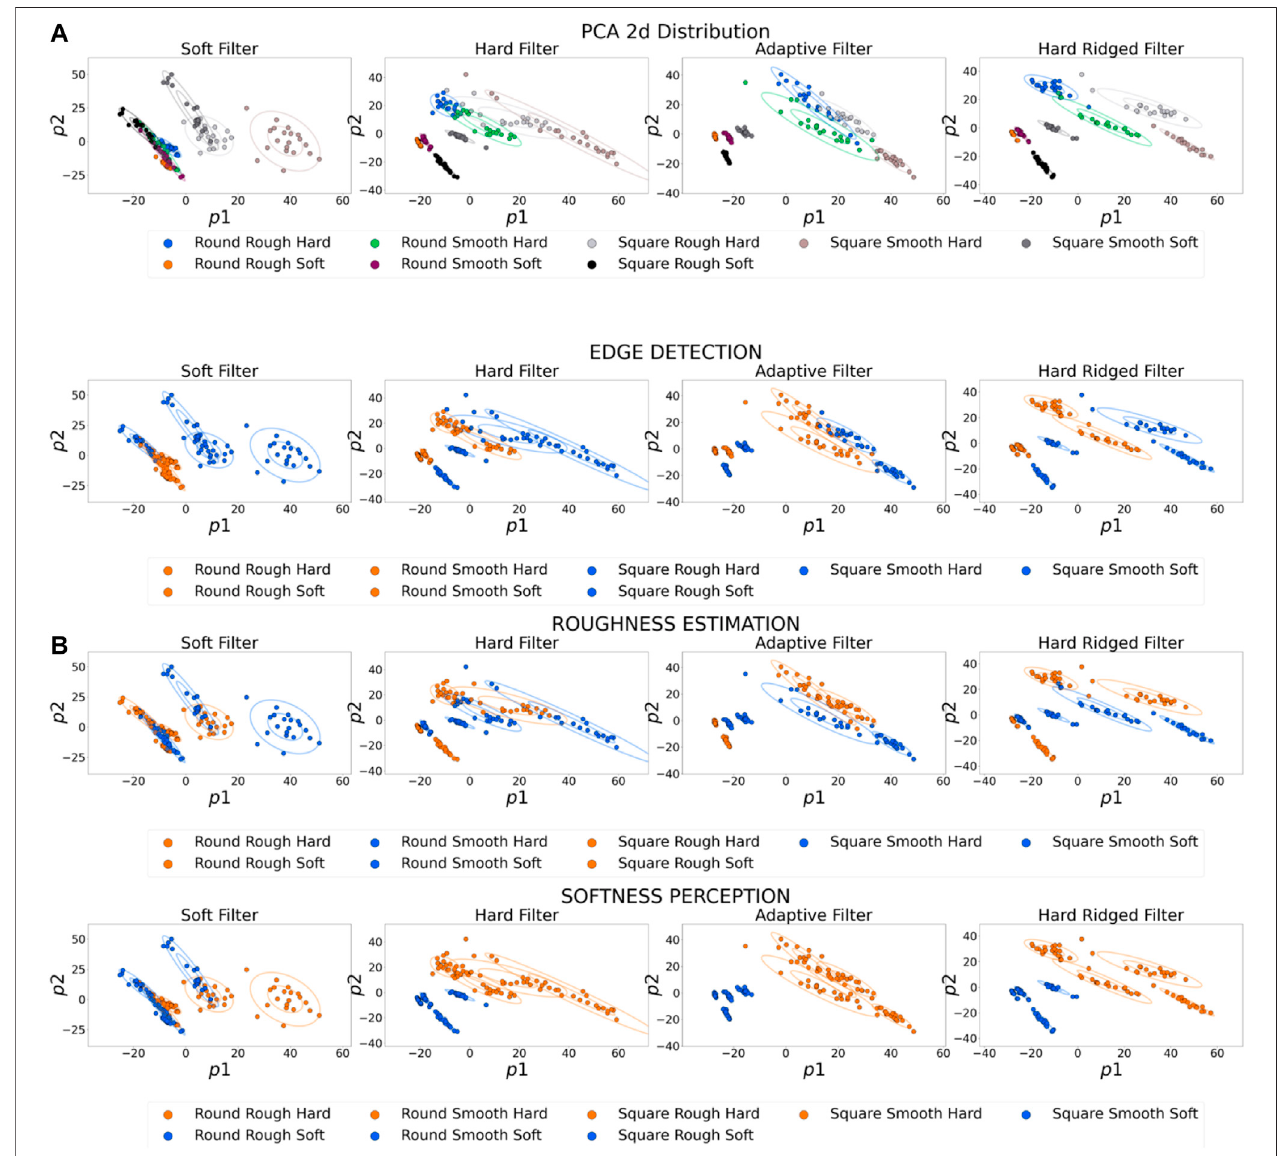
FIGURE 6 | PCA 2D projections of the sensor response. Each fi gure is generated via touch experiments with a different fi lter shape.